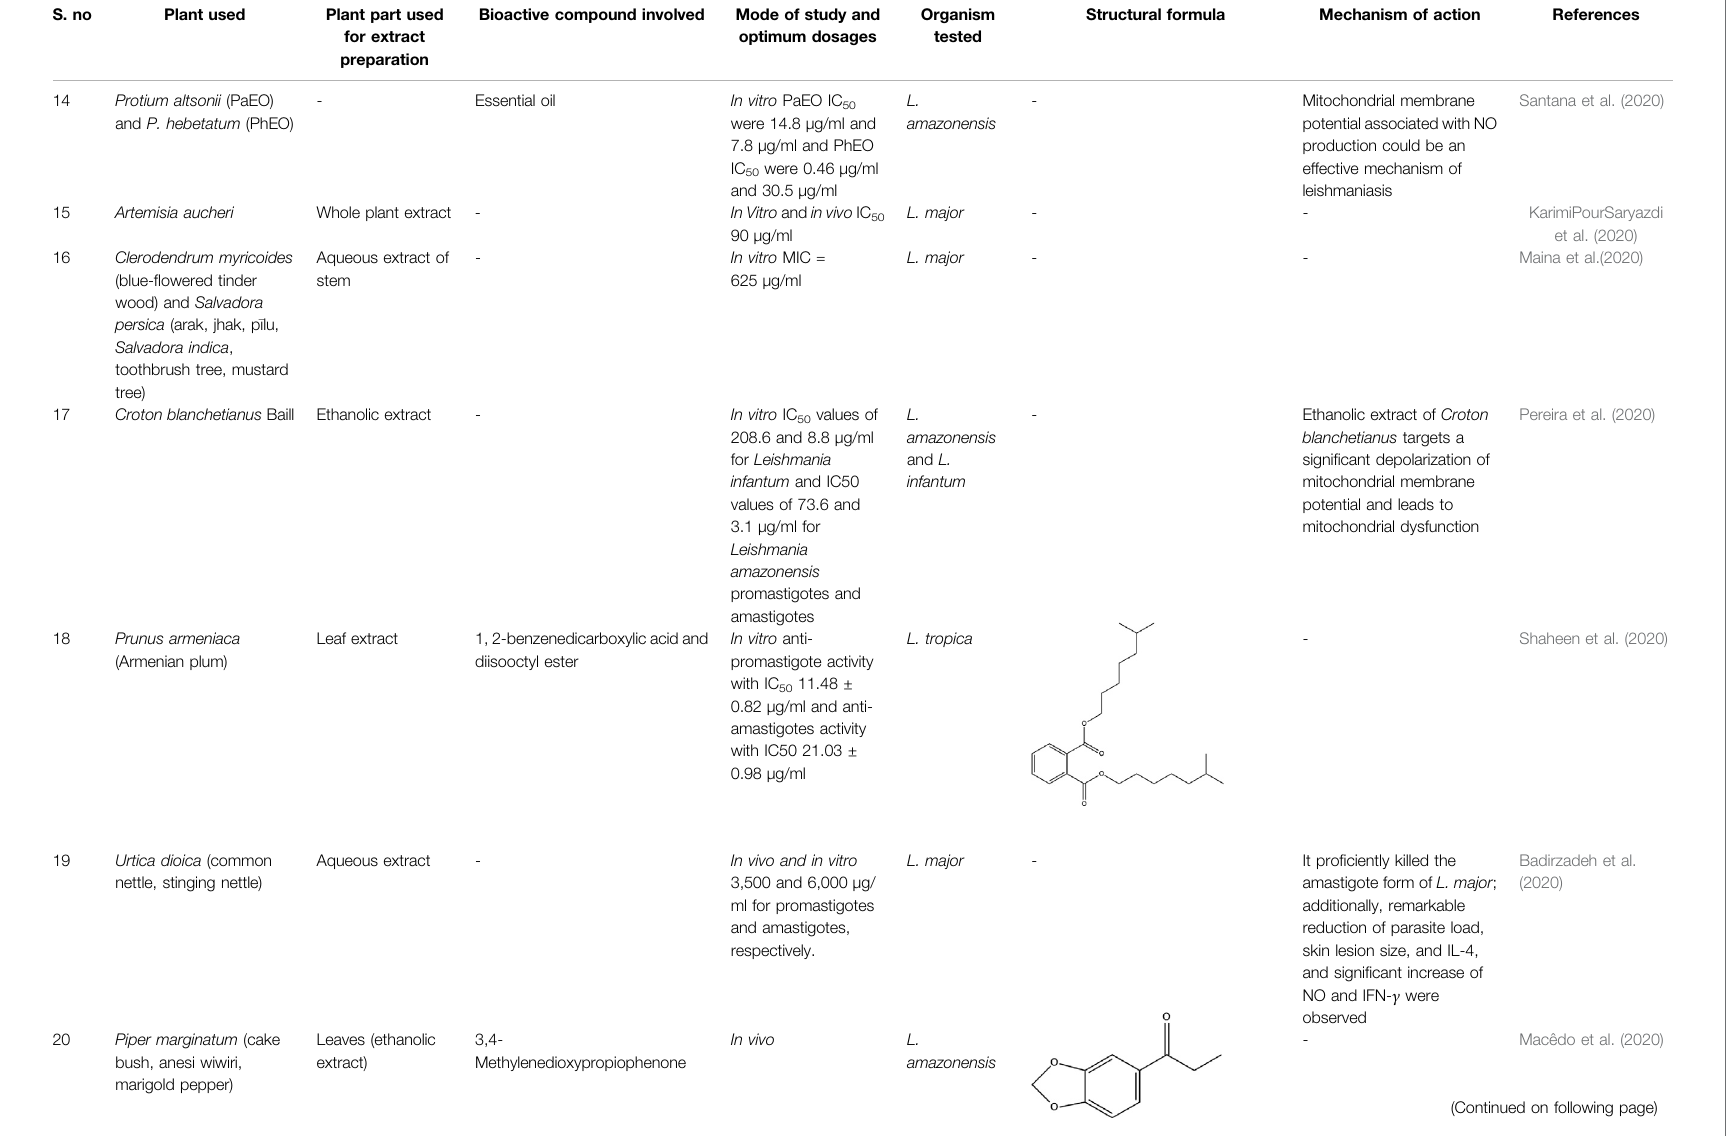
TABLE 1 | ( Continued ) Role of plant-based natural products in the treatment of